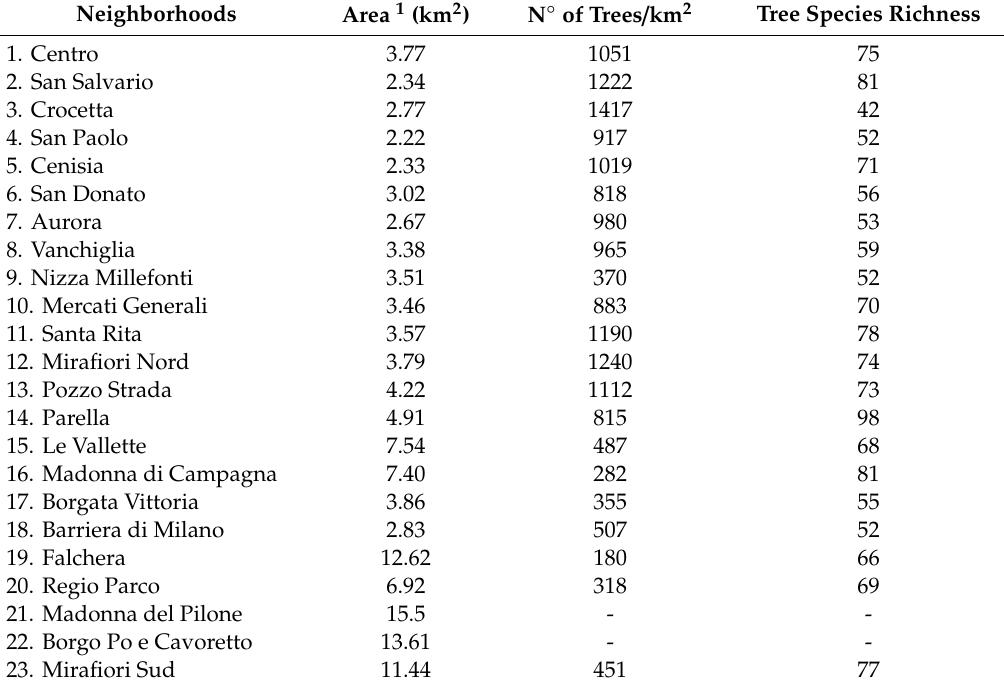
Table 3. Area, number of trees per km 2 , and tree species richness of Turin neighborhoods. Neighborhoods Area 1 (km 2 ) N ◦ of Trees / km 2 Tree Species